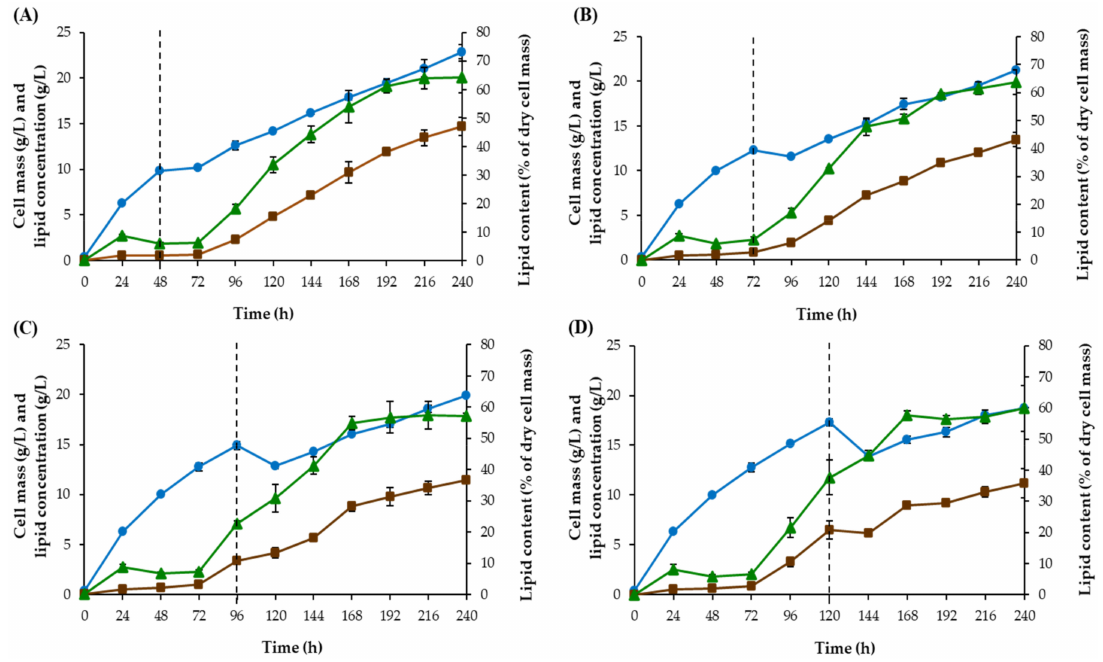
Figure 2. Time-course of cell mass ( • ), lipid content ( (cid:78) ) and lipid concentration ( (cid:4) ) of R. fluvialis DMKU-SP314 cultivated in a STH medium consisting of 70 g / L TRS, 2.58 g / L SBP, 0.94 g / L (NH 4 ) 2 SO 4 , 0.39 g / L KH 2 PO 4 , 2.5 g / L MgSO 4 7H 2 O, with an initial pH of 6, a temperature of 28 ◦ C and a